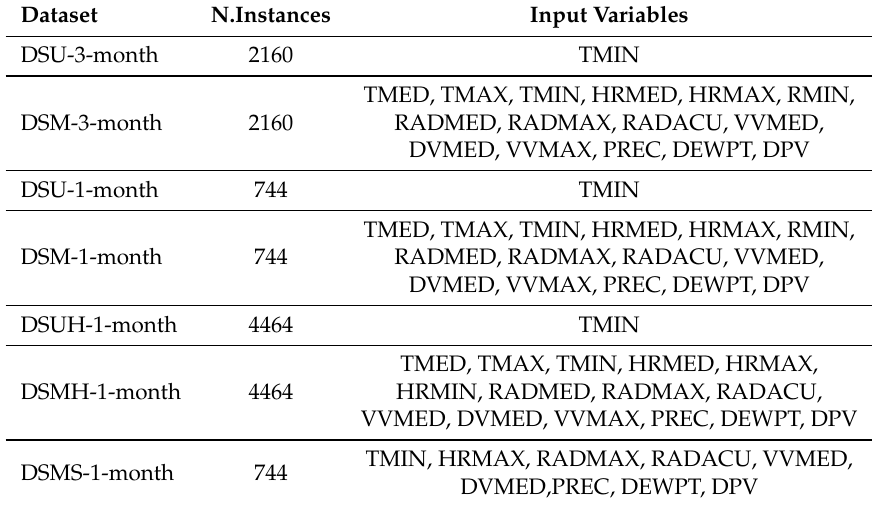
Table 1. Description of the datasets used for model validation, indicating number of instances of each dataset (N.Instances) and input variables (Input variables). The acronyms of these variables mean: TMED- mean temperature, TMAX- maximum temperature, TMIN-minimum temperature, HRMED-mean relative humidity, HRMAX-maximum relative humidity, HRMIN- minimum relative humidity, RADMED-mean radiation, RADMAX- maximum radiation, RADACU- accumulated radiation, VVMED-mean wind speed, DVMED- mean wind direction, VVMAX-maximum wind speed, PREC-rainfall, DEWPT- dew point, and DPV-pressure vapor deficit.